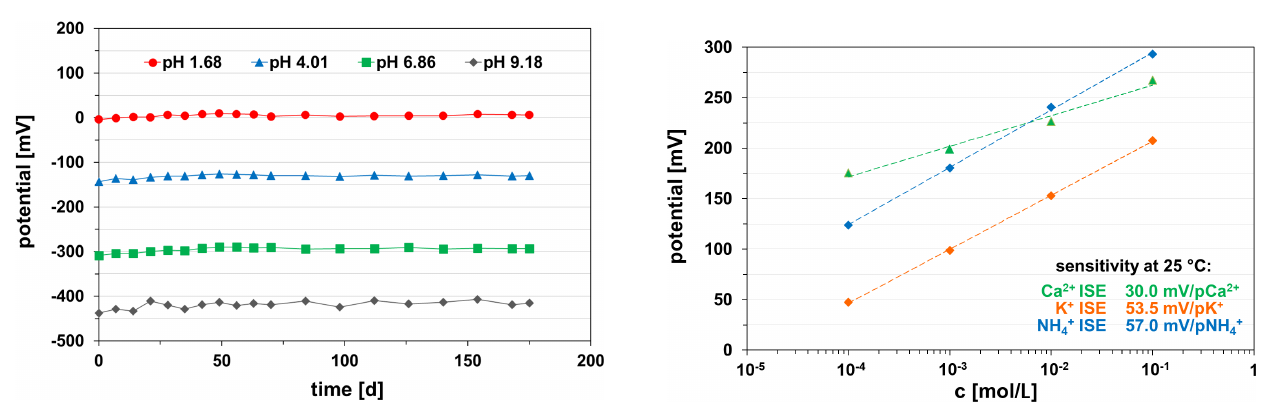
Figure 12. Calibration curves of ISEs (K + , NH measurement range of 10 − 1 to 10 − 4 M